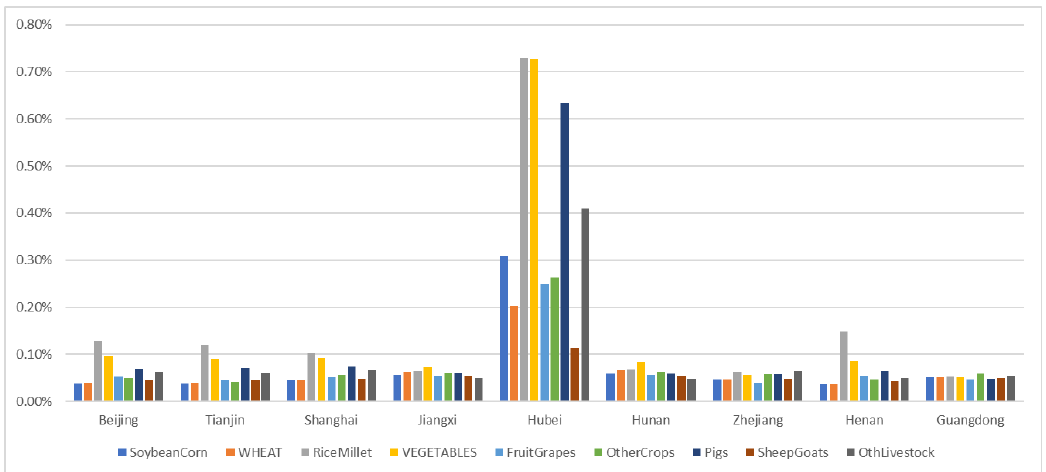
Figure 3. Under LIS scenario, price changes in Beijing, Tianjin, Shanghai, Jiangxi, Hubei, Hunan, Zhejiang, Henan, and Guangdong.